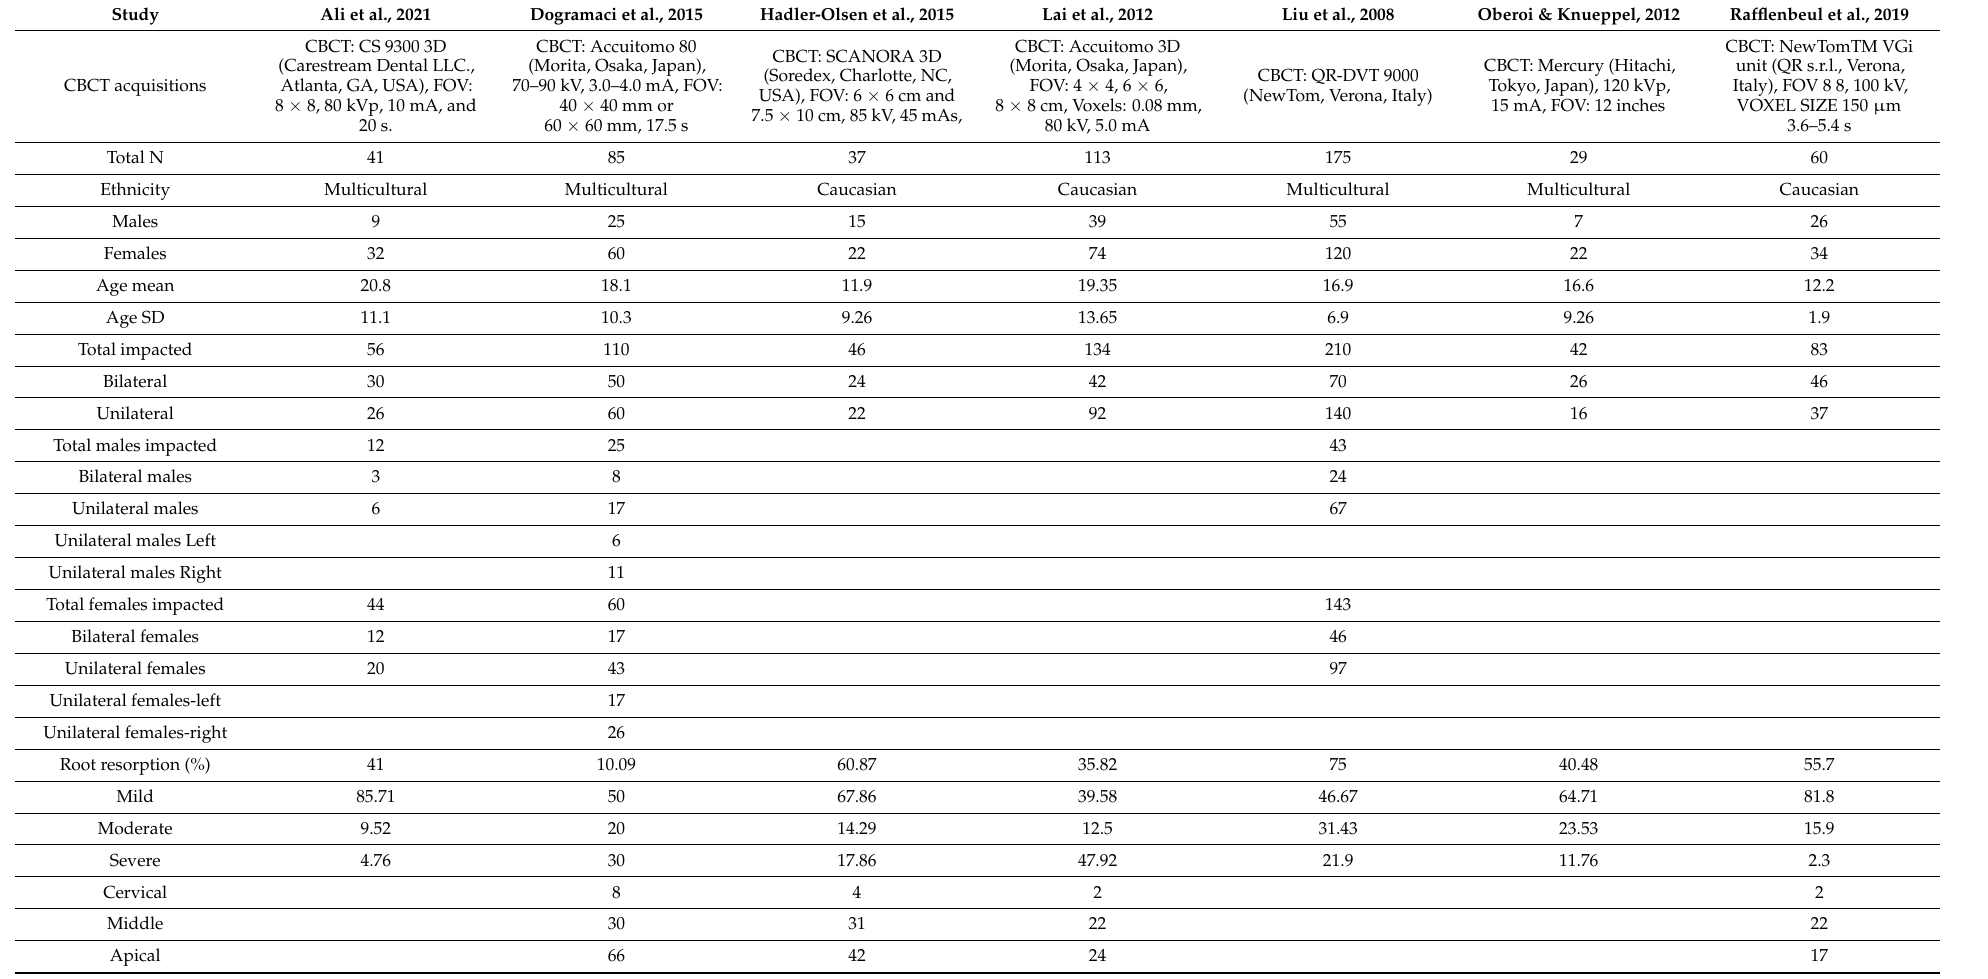
Table 1. The demographics of participants in the included studies